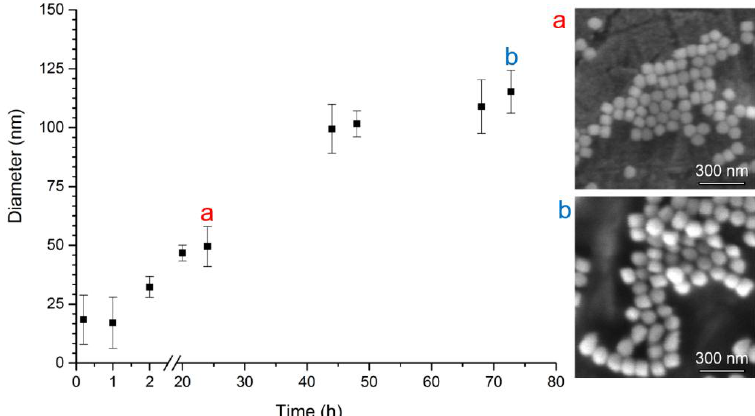
Figure 4. Dependence of CdTe/SiO 2 QDs average hydrodynamic particle diameter (nm) on time (hours) of silica shell growth in ethanol presence. The number of DLS measurements per one exposure time was 5; error bars correspond to standard deviations. SEM photograh ( a ) after 24 h growth (diameter 62.3 ± 7.5 nm) and ( b ) after 72 h growth (diameter 83.1 ± 6.9 nm).